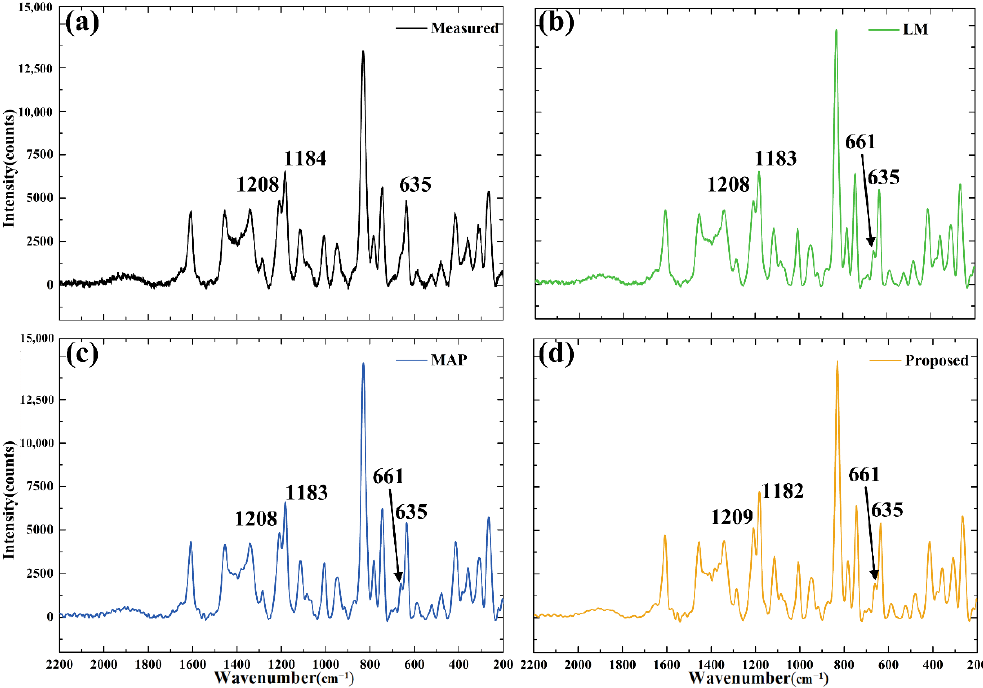
Figure 11. ( a ) Ibuprofen (C 13 H 18 O 2 ) measured spectrum and reconstructed spectra with spectral range from 2200 to 200 cm −1 by ( b ) the LM method; ( c ) the MAP method; ( d ) the proposed method.